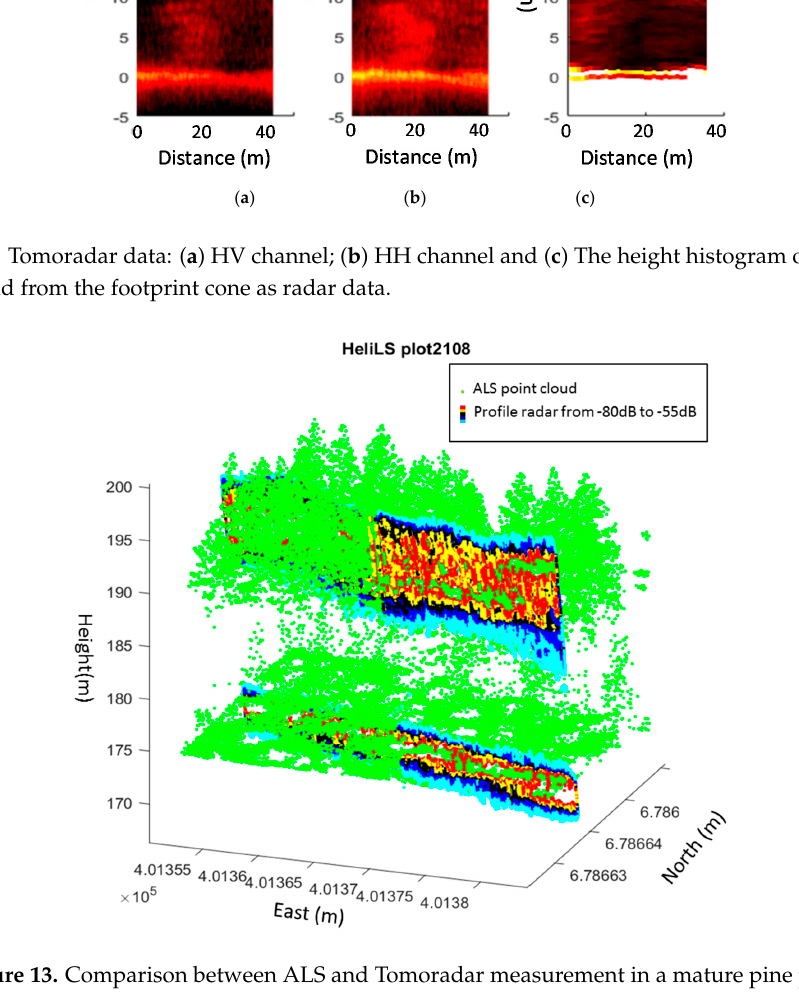
Figure 13. Comparison between ALS and Tomoradar measurement in a mature pine plot.